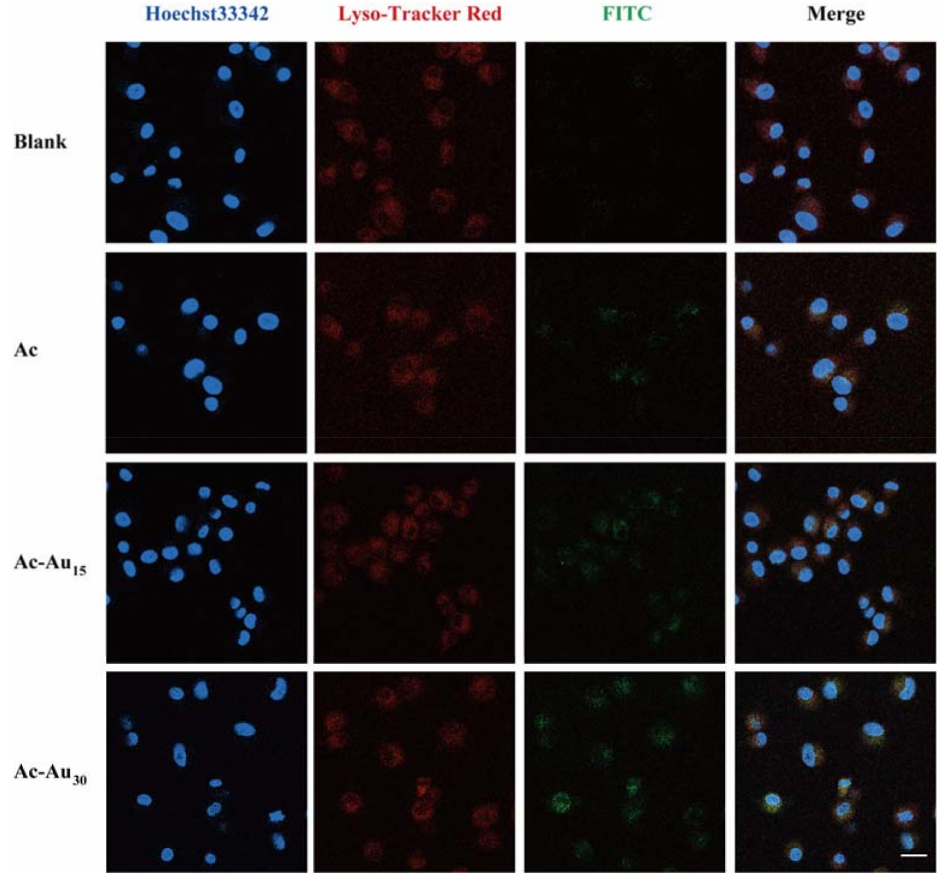
Figure 5. Confocal fluorescence microscopic images of U87MG cells after 6 h of co-incubation with the formed dendrimers. The fluorescence of Hoechst 33342, Lyso-Tracker Red and FITC were pseudo-labeled with blue, red, and green fluorescence, respectively. Scale bars: 20 µ